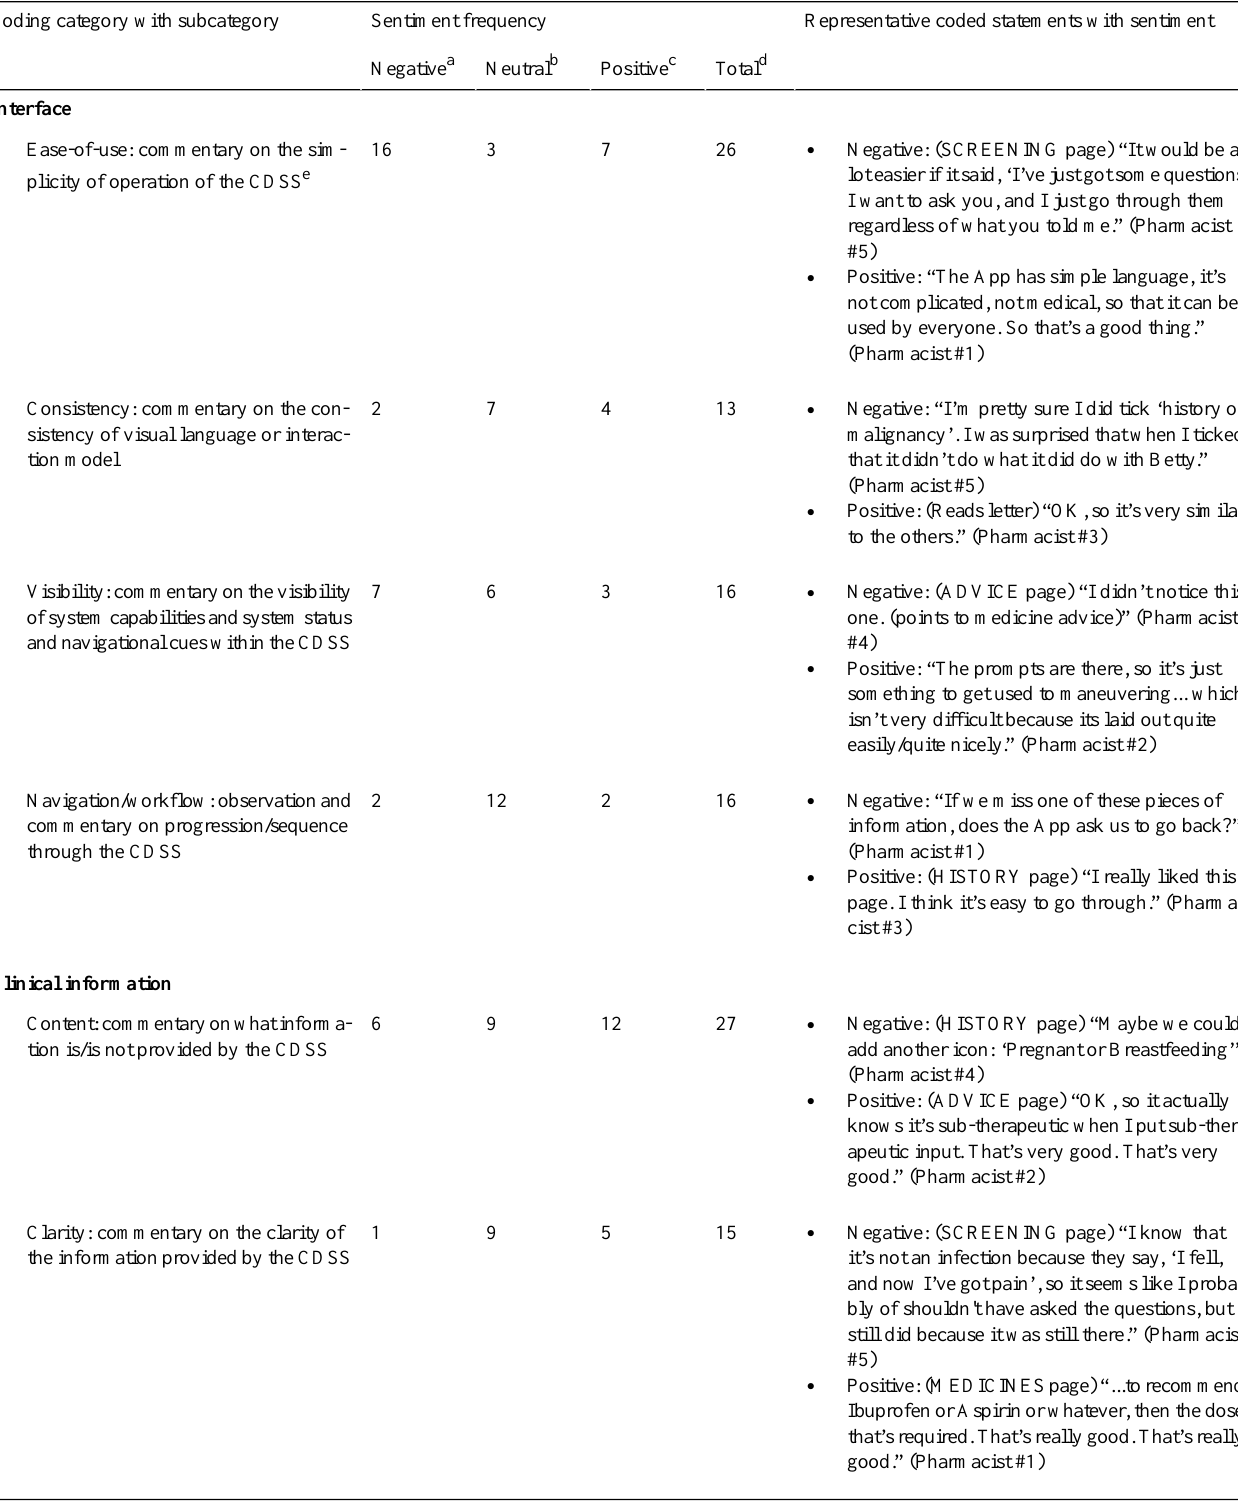
Table 1. Coding categories with statement frequency and representative examples.